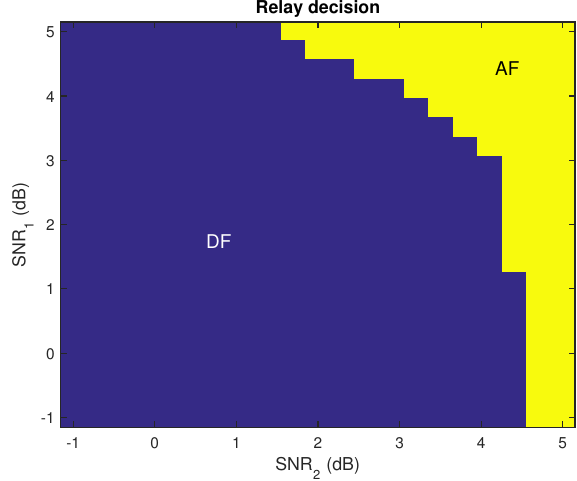
Figure 7. Relay decision map, shown for R 1 =